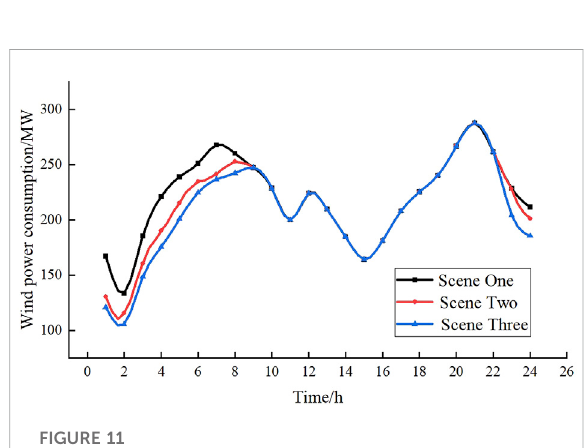
FIGURE 11 Comparison of wind power consumption in three